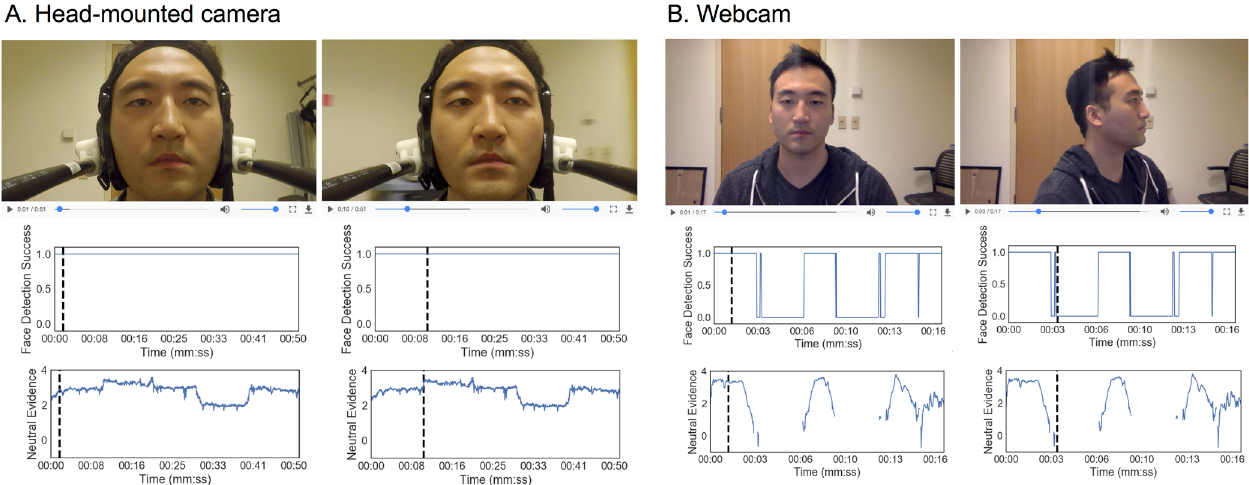
Figure 3. Face detection reliability between a head-mounted camera and webcam setup. ( A , B ) Top row images show the face recordings when facing forward and the right panel image shows the face when facing left. Graphs in the middle row show face detection success at each frame. Graphs in the bottom row shows neutral face expression predictions. In ( A ), facial expressions are predicted in all frames in contrast to ( B ) where face detection and facial expressions predictions fail when the head is rotated away from the